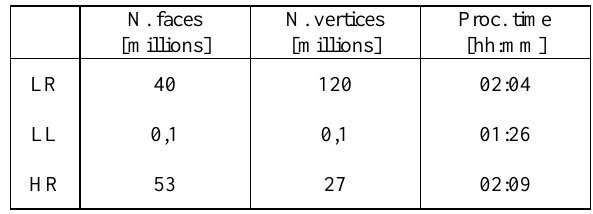
Table 7. UAV mesh statistics.